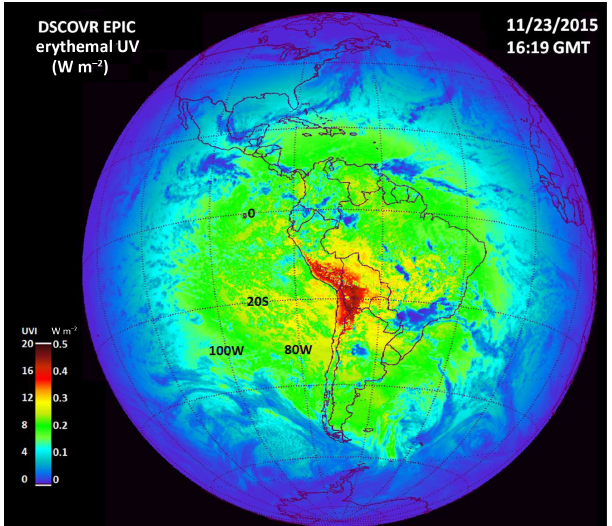
Figure 18. Erythemal irradiances centered over South America on 23 November 2015 at 16:19 UTC showing extremely high values in the Andes Mountains in Peru, Bolivia, and Chile corresponding to a UV index greater than 20. Local solar noon is at 64.75 ◦ W and overhead near 20 ◦ S.